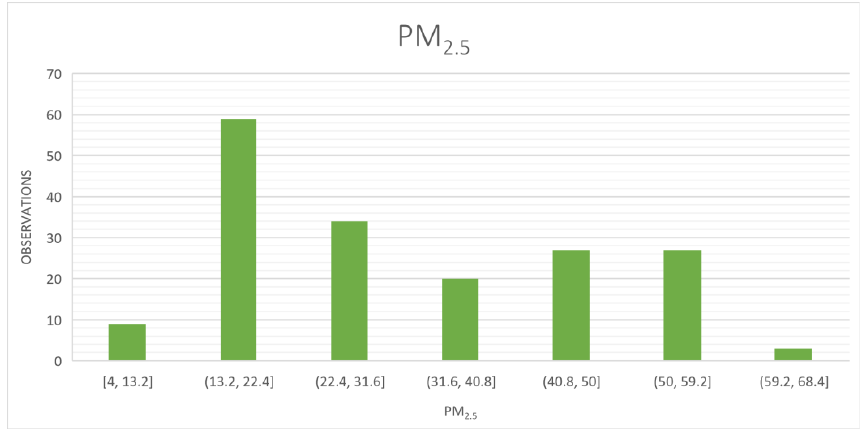
Figure 14. Hourly air pollution (PM 2.5 ), 2010 – 2015. [Note: When displaying numerical data, a histogram divides the data into "bins" of equal width. Each bin is represented graphically by a bar whose height reflects the number of data points it contains. The range of the numbers is symbolized with either round brackets (or parentheses) or square brackets, depending on the meaning of each bin. The round brackets are used for numbers that are not contained in the bin, and the square brackets are used for numbers that are part of a bin. For example, at Figure 14, the second bin, namely (13.2, 22.4], means that the number 13.2 is not contained at its range, but the number 22.4 is part of the specific range].